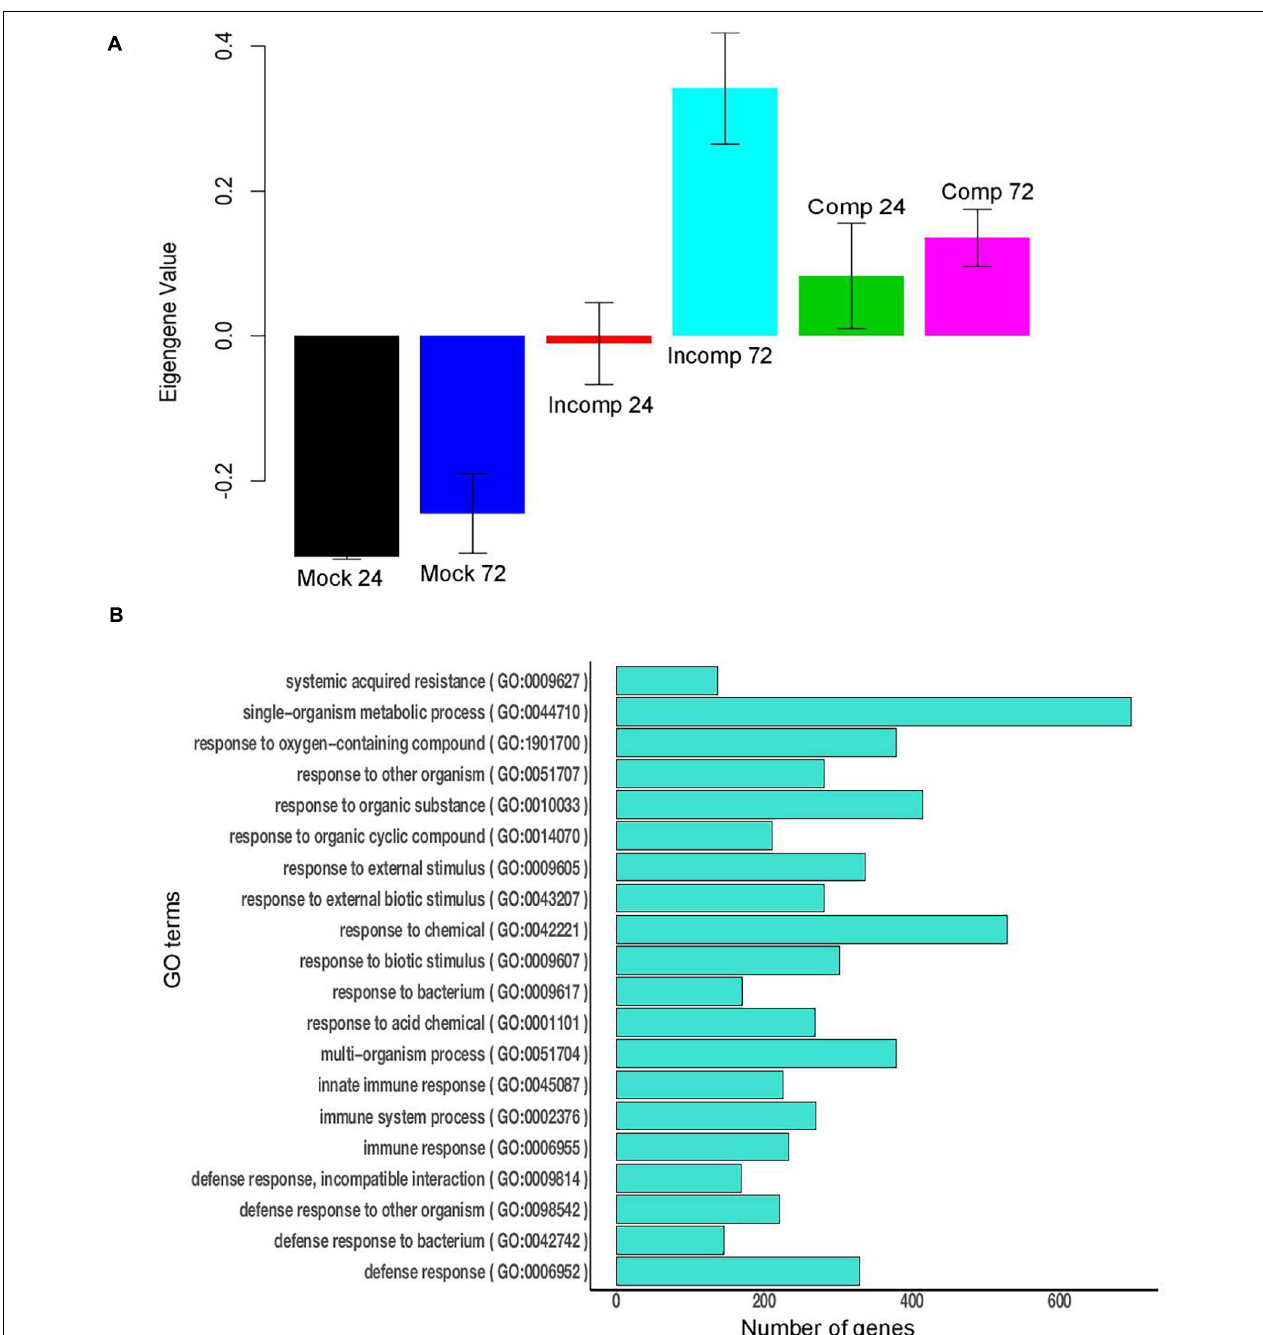
FIGURE 4 | Module 6 of maize contains 1,277 genes. (A) Bar plot of module eigengene expression values for different groups. “Mock 24” indicates mock at 24 h after inoculation (hai), “Mock 72” indicates mock at 72 hai, “Incomp 24” indicates incompatible interaction at 24 hai, “Incomp 72” indicates incompatible interaction at 72 hai, “Comp 24” indicates compatible interaction at 24 hai, and “Comp 72” indicates compatible interaction at 72 hai. Error bars indicate standard deviations of the mean of three biological replicates. (B) The 20 highly significant GO terms (FDR < 0.05) enriched in module 6 of maize.